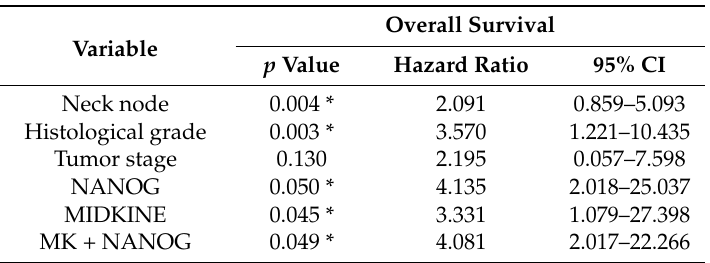
Table 3. Multivariate Cox proportional hazards regression analysis for variable in relation to overall survival of 62 OSCC patients.